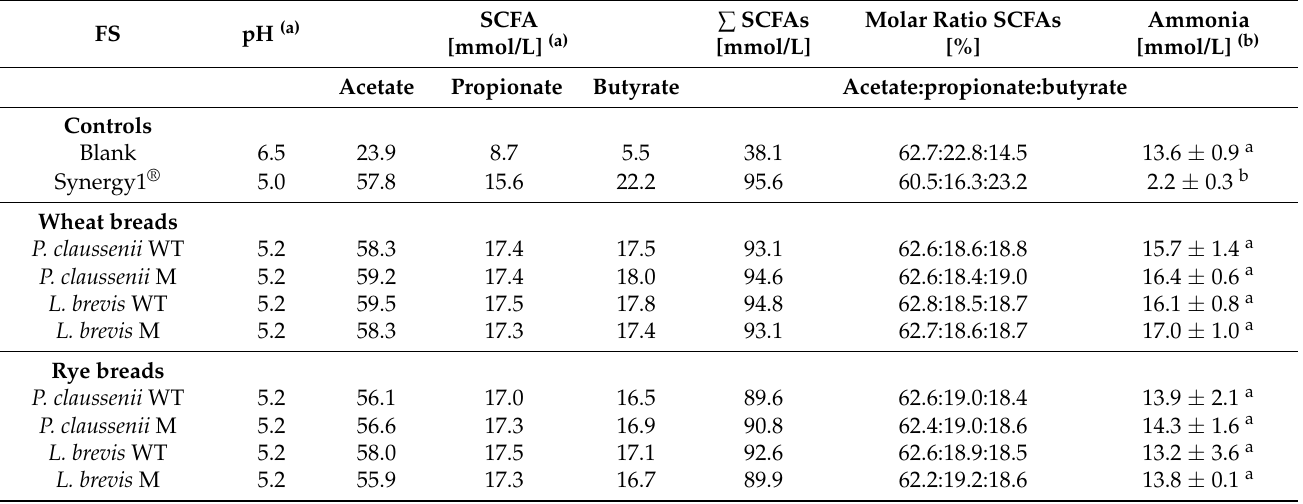
Table 4. pH values, SCFA concentrations, molar ratios of main SCFAs and ammonia concentrations in FS of